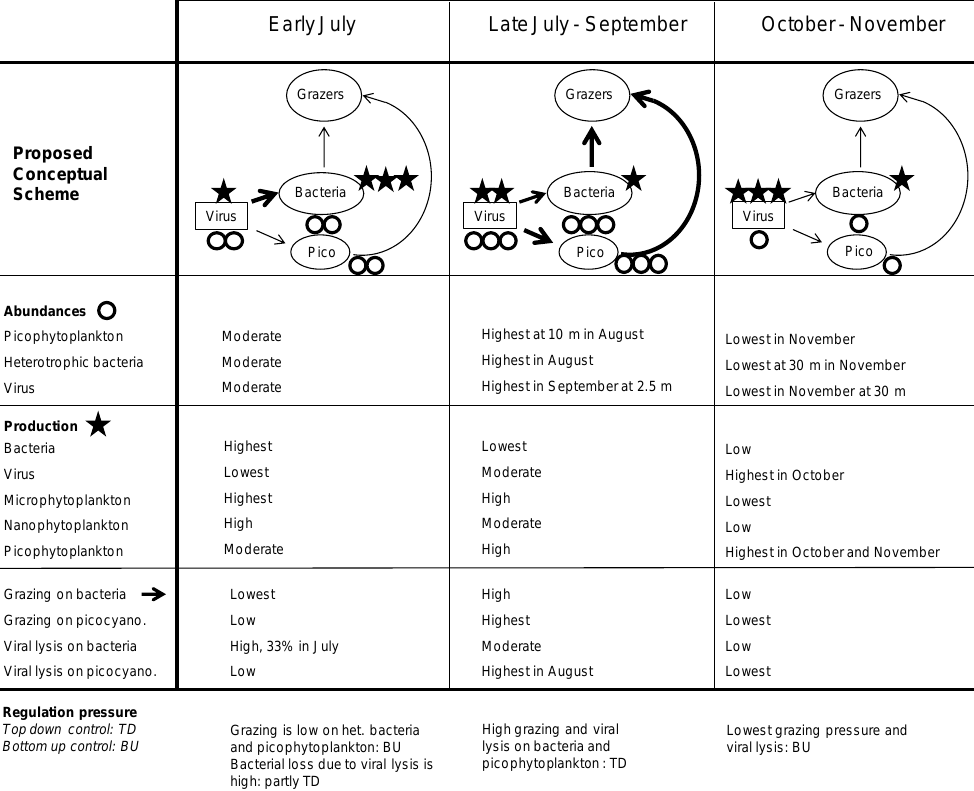
Fig. 7. Conceptual scenario for the seasonal succession of two major constituents of the microbial food web (the heterotrophic bacteria and the picophytoplankton) in upper layers (0–20m) of Lake Geneva between July and November